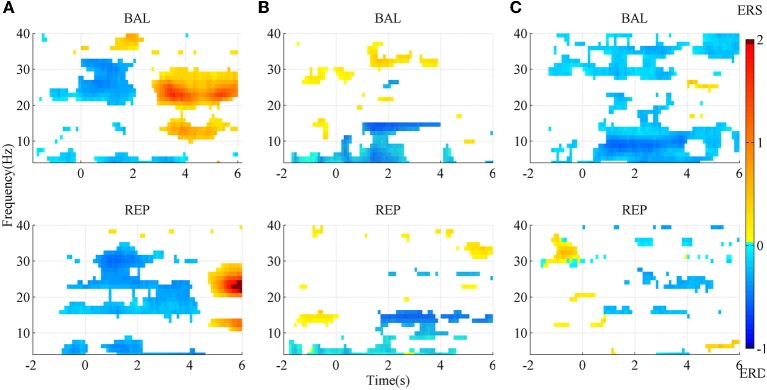
SMR mapping from three representative subjects. (A) subject A; (B) subject B; (C) subject C. BAL and REP stand for ballistic and repetitive task, respectively. Only those points with significance in bootstrap test are presented. Red area indicates ERS, while blue area is ERD.